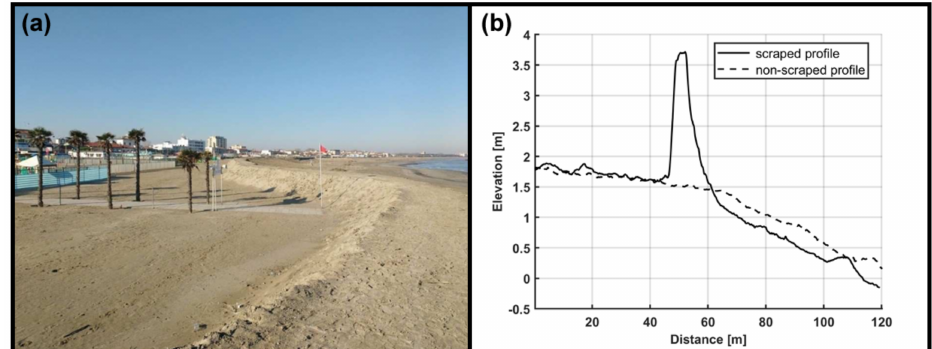
Figure 4. The artificial dune at the study site on the 21 December 2016: ( a ) northward view from the top of the dune (Photo: Enrico Duo), and ( b ) comparison of scraped and non-scraped profiles (profile locations are shown in Figure